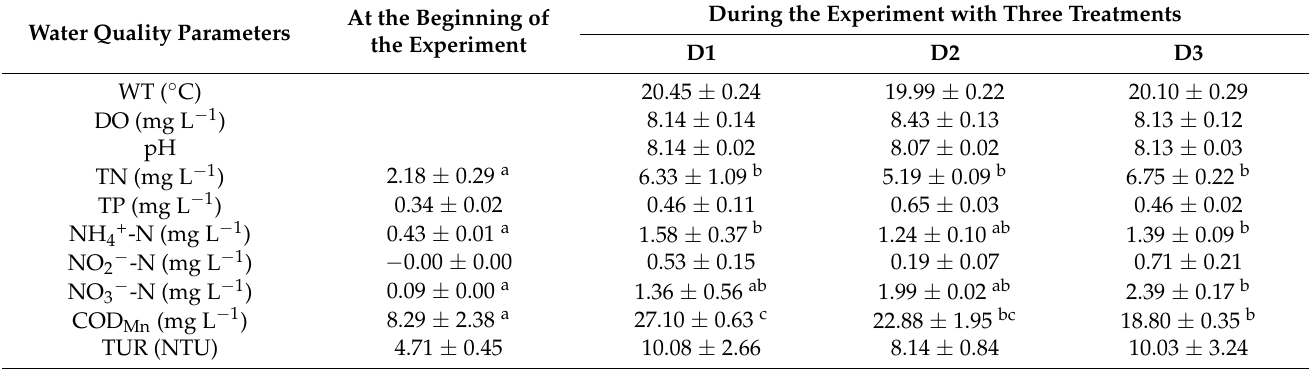
Table 1. Water quality parameters (mean ± SE) at the beginning of the experiment and during the experiment with three different treatments. The WT, DO, and pH values were observed for 55 days. The letters within the columns indicate significant differences among different treatments ( p <